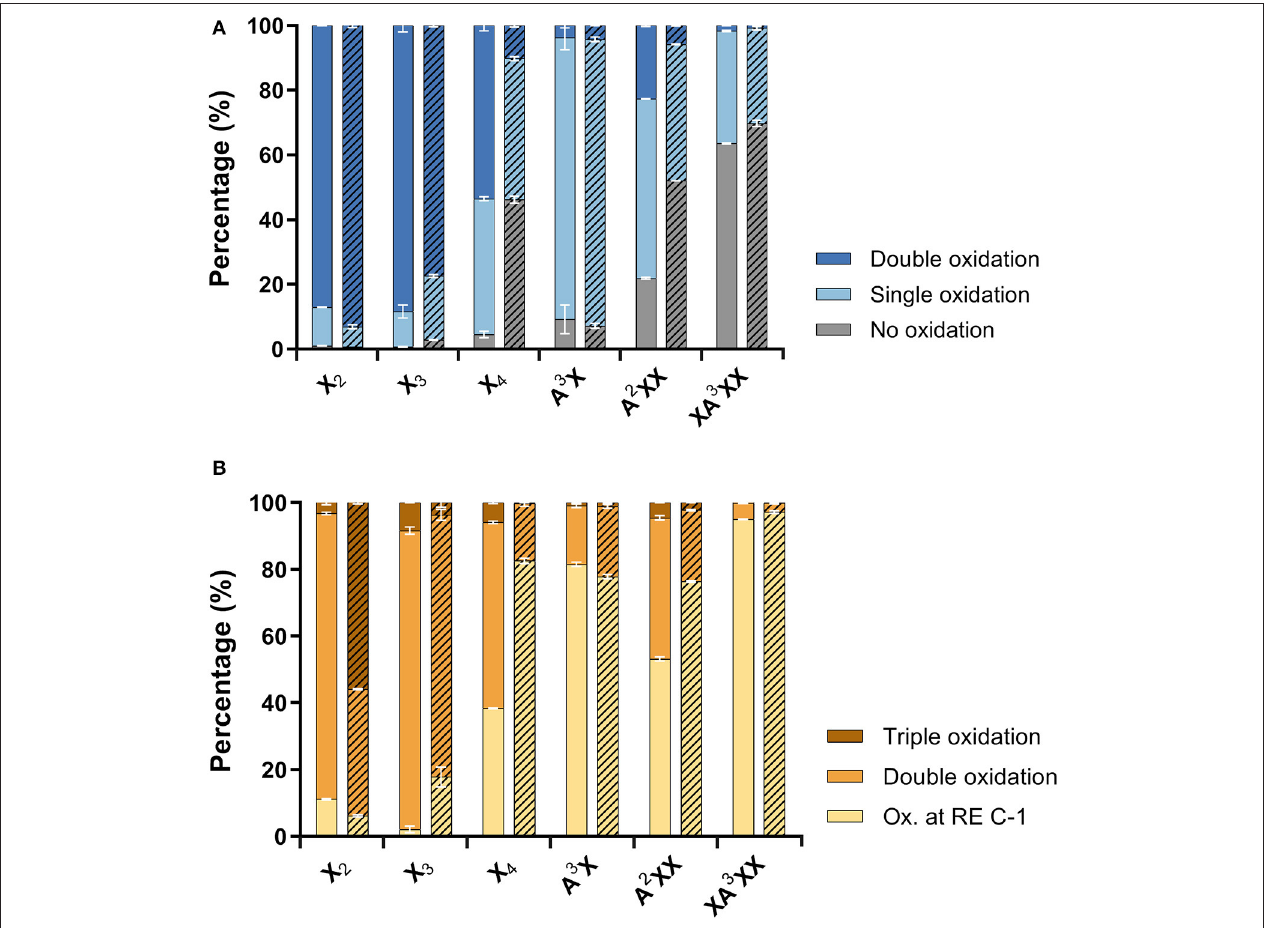
FIGURE 4 | Distribution of (A) neutral products (unreacted substrate and oxidations at secondary hydroxyls) and (B) acidic products (reducing end C-1 oxidation with zero, one or two secondary hydroxyls oxidations). Reactions with AbPDH1 are indicated by solid color and reactions with AmPDH1 are indicated by diagonal